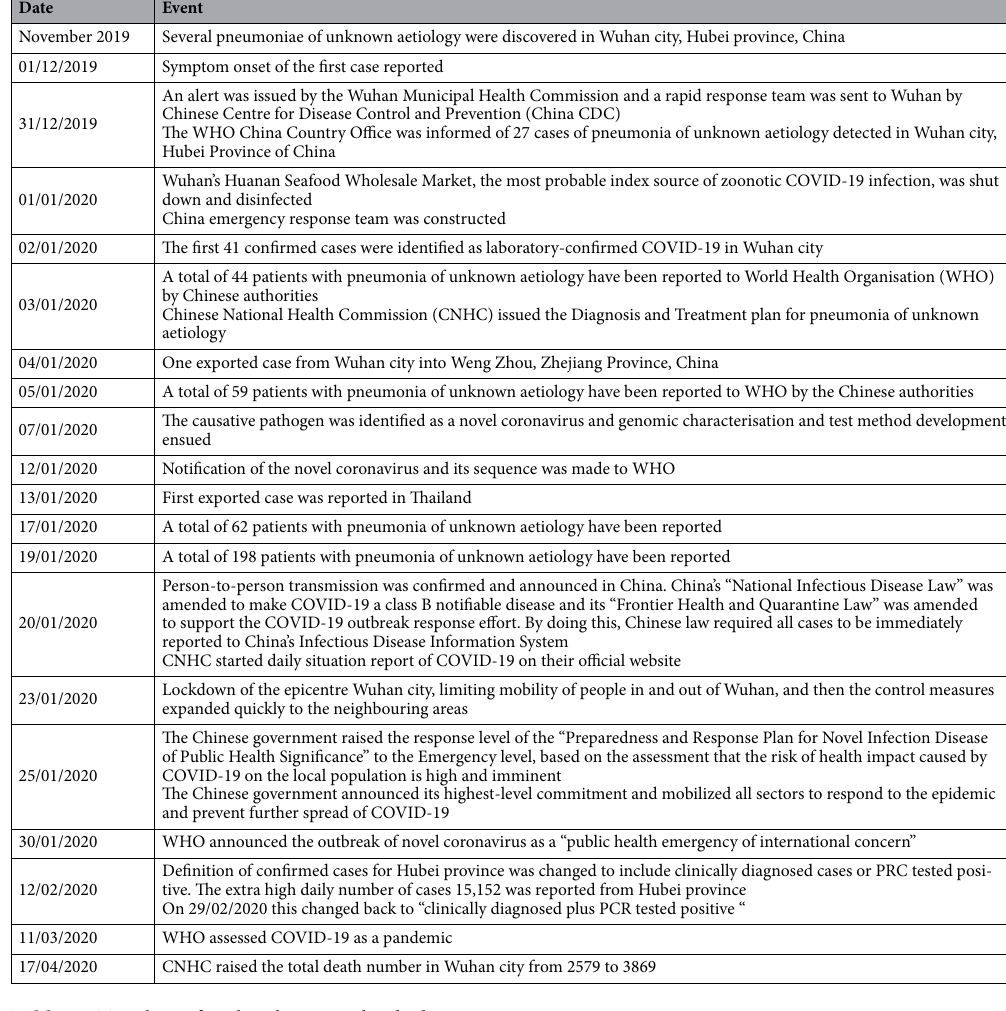
Table 1. Timeline of outbreak in mainland